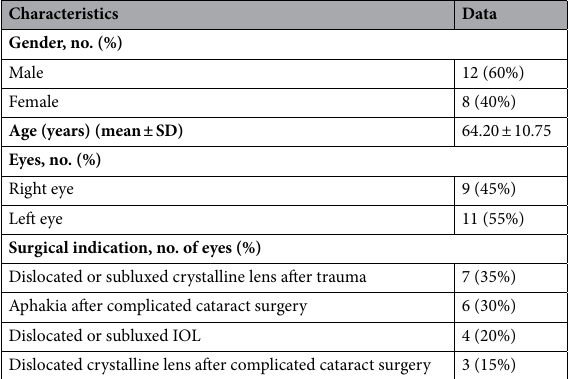
Table 1. Baseline patient characteristics.